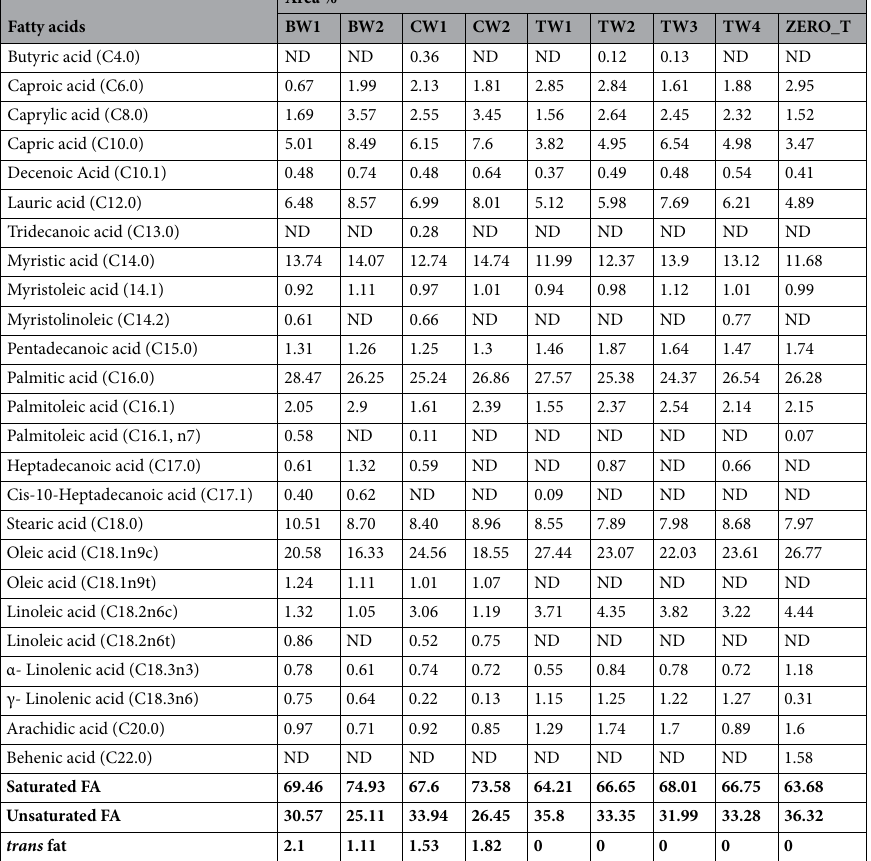
Table 4. Fatty acids profile of lipids extracted from cheese samples. ND Not detectable.